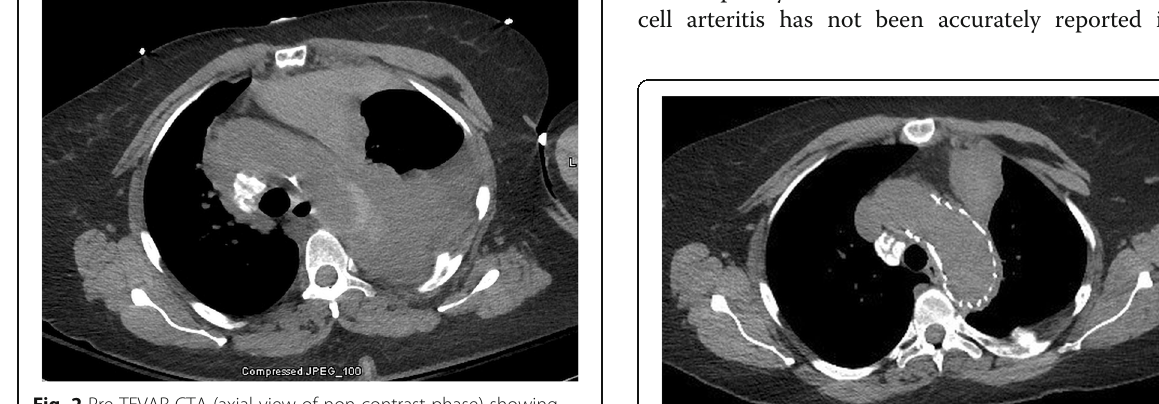
Fig. 2 Pre-TEVAR CTA (axial view of non-contrast phase) showing crescentic aortic IMH originating in the distal aortic arch near the takeoff of the left subclavian artery and large left sided hemothorax